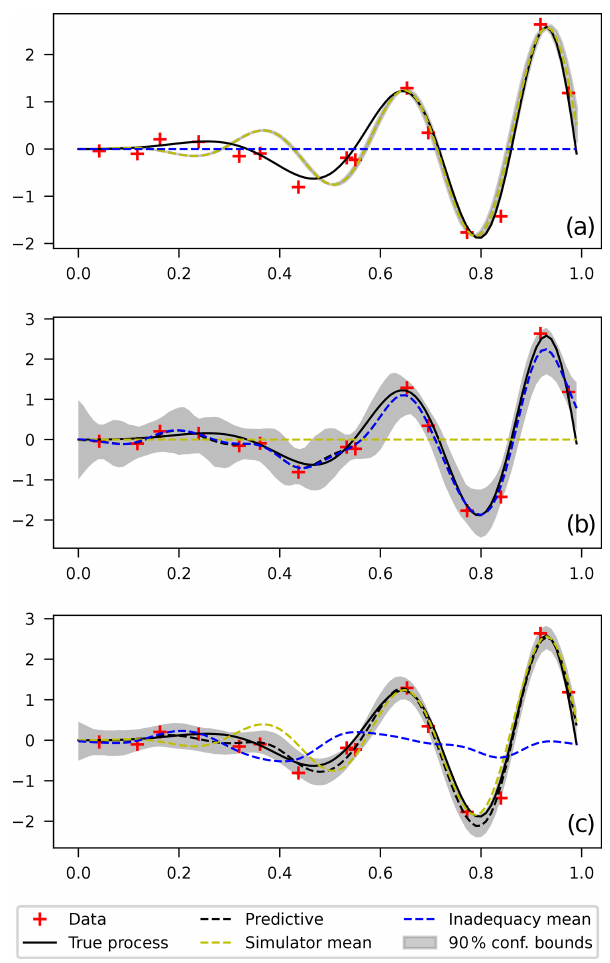
Figure 2. (a) Calibration using computational model only, (b) cal- ibration using inadequacy function only, and (c) calibration using computational model and an additive inadequacy